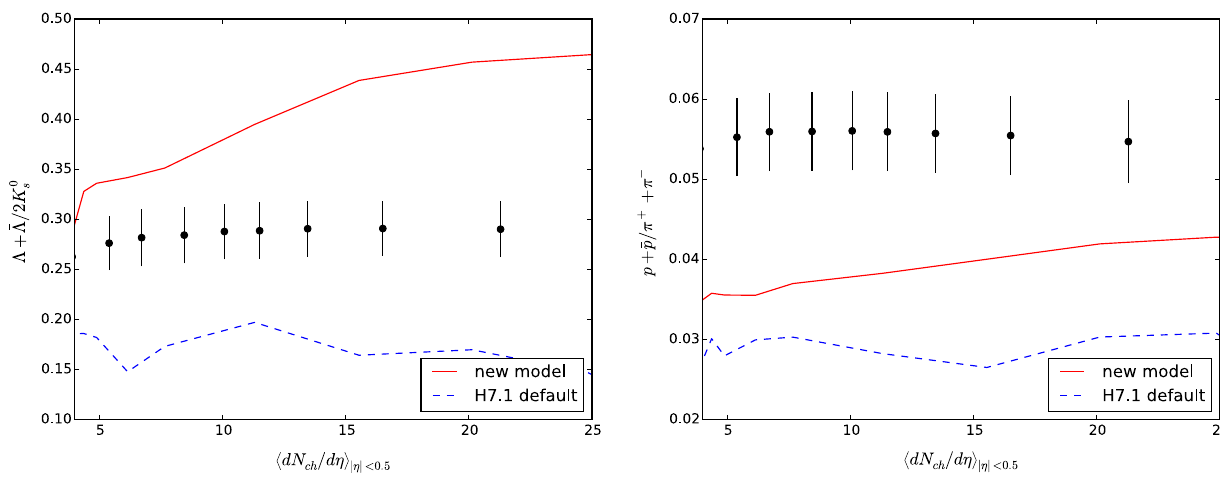
Fig. 15 Integrated particle yield ratio of (cid:6) + ¯ (cid:6)/ 2K 0 s and p + ¯ p /π + + π − as a function of (cid:10) d N ch / d η (cid:11) for | η | < 0 . 5. The values from the ALICE analysis [6] are compared to calculations from Herwig 7.1 with the old model and the new model for colour reconnection